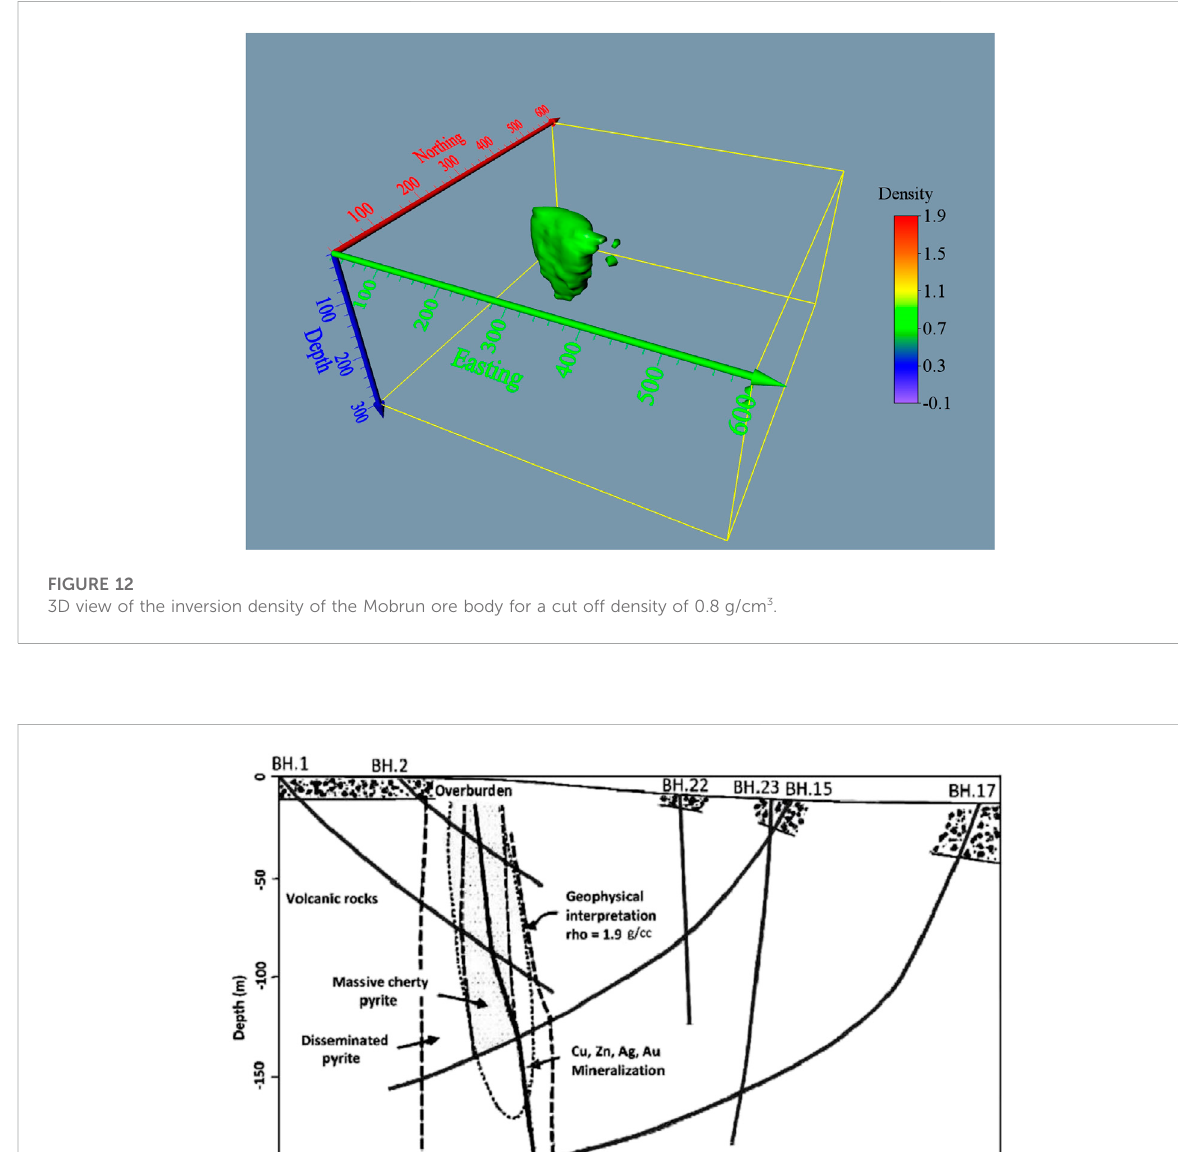
Frontiers in Earth